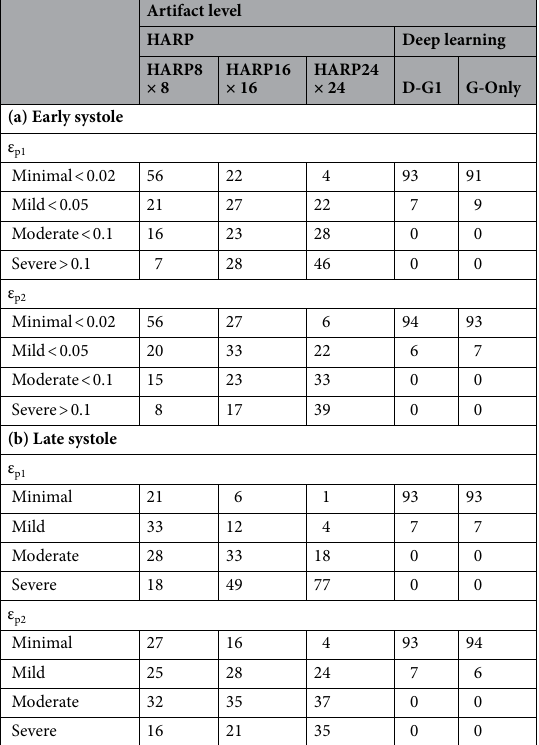
Table 2. Subjective evaluation of the level of artifacts in DL versus HARP methods in 100 randomly chosen 5 mm × 5 mm image patches during (a) early systole and (b) late systole